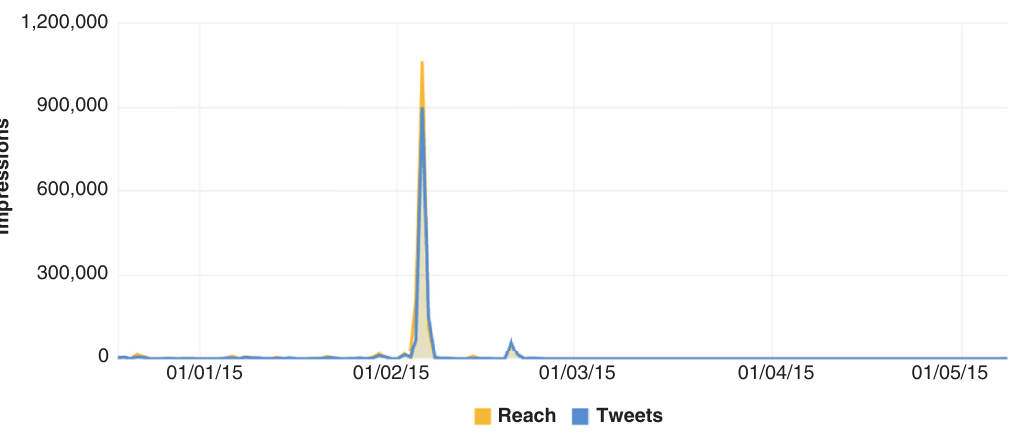
Figure 2. Number of Twitter impressions as a function of time, expressed both as tweets and reach + ; reproduced from data reports obtained from the website http://www.followthehashtag.com. + Reach is defined as the number of observers of the tweet, based upon the number of followers of the user and the followers of any participants, responses, or retweets.